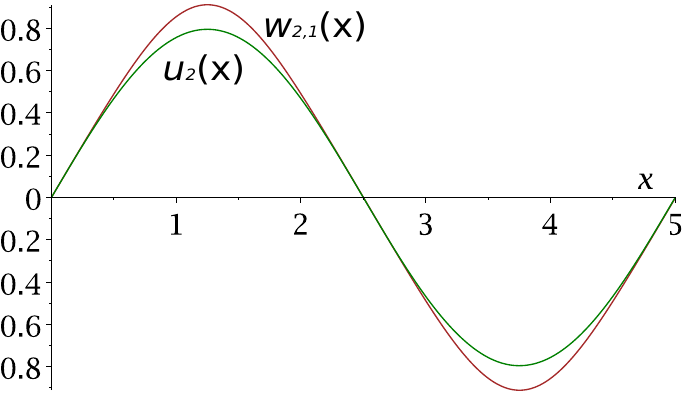
Figure 6. Eigenfunctions u 2 = 5 , respectively. Q (cid:48)